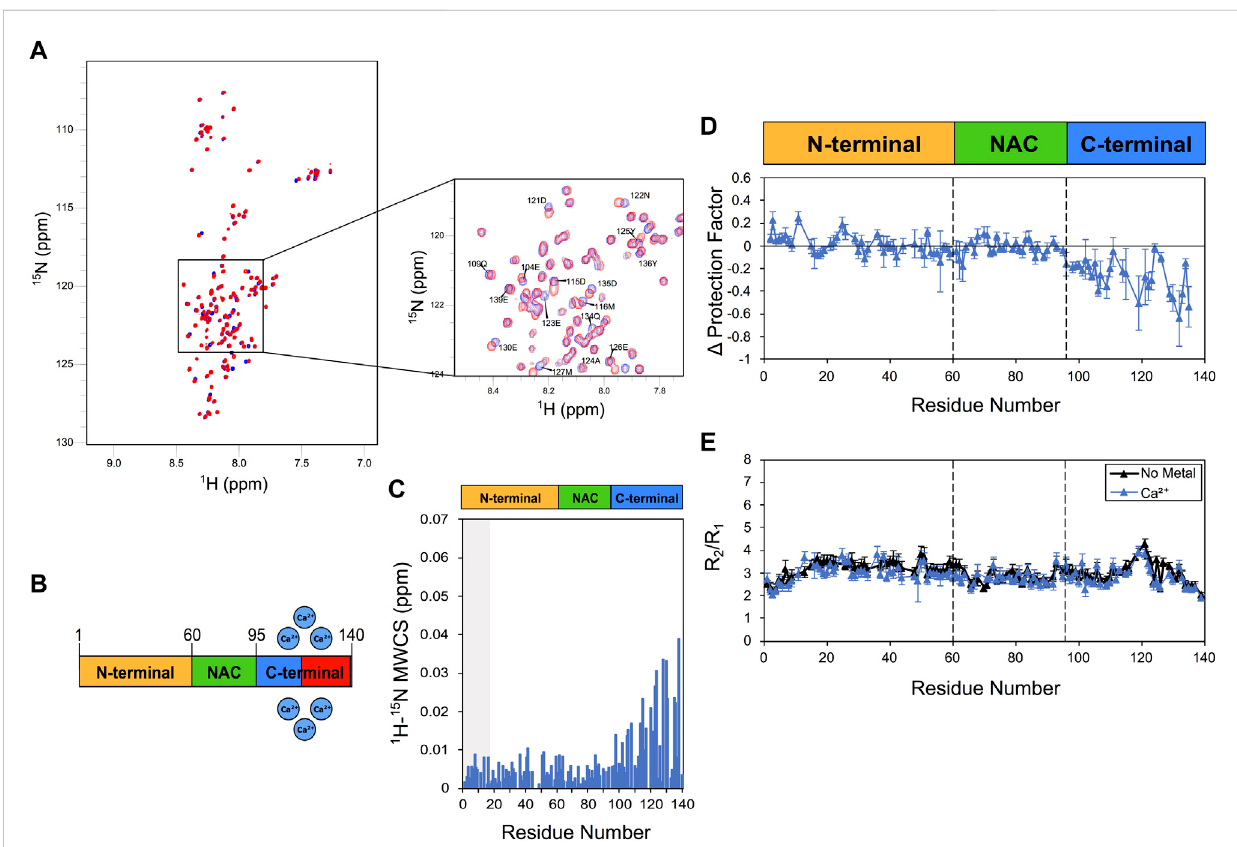
FIGURE 1 NMR analysis of Ca 2+ binding to α S. Experiments were performed at 10 ° C in 25 mM Tris buffer and a pH of 7.0, and using concentrations of α S and Ca 2+ of415 μ Mand10 mM,respectively. (A) 1 H- 15 NHSQC spectraof α Sinthepresence(blue)andabsence(red)ofcalcium. (B) Schematic depicting Ca 2+ bindingby α S.RedregionsintheschemeindicatemajorCSPalongthe α Ssequenceuponmetalbinding. (C) MeanweightedCSP( 1 H- 15 NMWCS)of α Sasa result of the calcium binding. The grey box denotes the fi rst 15 residues of the protein. (D) Alteration in the LogP values of α S as a result of Ca 2+ binding as measured in CLEANEX experiments (Supplementary Figures S5, S6). These values are calculated for each α S residue as the logP of the metal bound state minus the logP of the isolated protein state. (E) R 2 /R 1 values from 15 N relaxation data of α S in the presence (blue) and absence (black) of calcium (raw data in Supplementary Figure S7). Error bars are calculated from the fi tting errors in R 1 and R 2 measurements. Dotted lines delineate the different regions (N-terminal, NAC and C-terminal) along the sequence of α